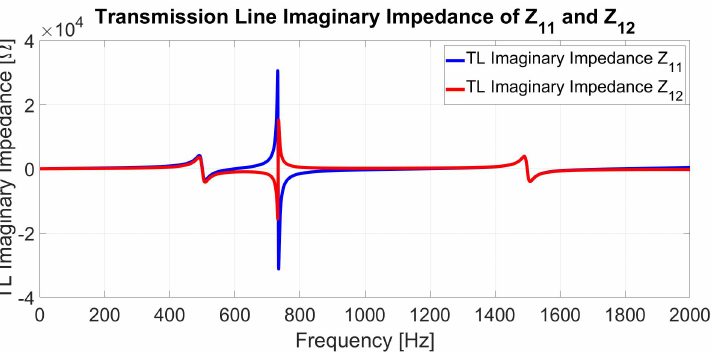
Figure 12. Frequency response measurements of transmission line imaginary impedance ( Z 11 and Z 12